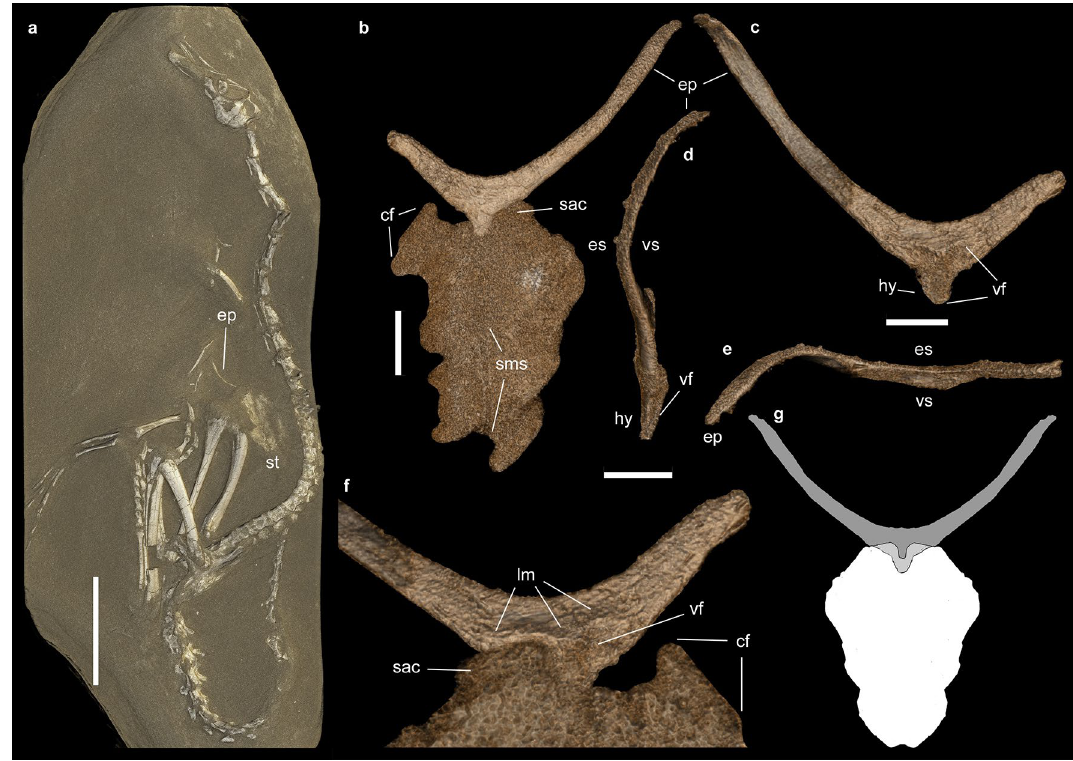
Figure 2. The furcula-sternum complex in Halszkaraptor escuilliei MPC D-102/109. ( a ) Exposed elements of H. escuilliei holotype. ( b ) Furcula and sternum in ventral view. ( c ) Furcula in dorsal (visceral) view. ( d ) Furcula in left lateral view. ( e ) Furcula in anterior (proximal) view. ( f ) Detail of the sternofurcular articulation in dorsal (visceral) view. ( g ) Reconstruction of the furcula-sternum complex in dorsal (visceral) view. Dark grey, exposed furcula; light grey, posterior region of furcula overlapped by the sternal plates; white, sternal plates. cf coracoid facet, ep epicleideum, es “external” side of the bone, hy hypocleideum, lm lipped margin of visceral fossa, sac sternal anterior end covering the furcula, sms sternal plates midline suture, st sternal plates, vf visceral fossa, vs “visceral” side of the bone. Scale bars: 70 mm ( a ), 8 mm ( b ), 6 mm ( c–e ). Visualization by VB using Volume Graphics vers. 2.2. (Heidelberg, Germany: https:// www. volum egrap hics.